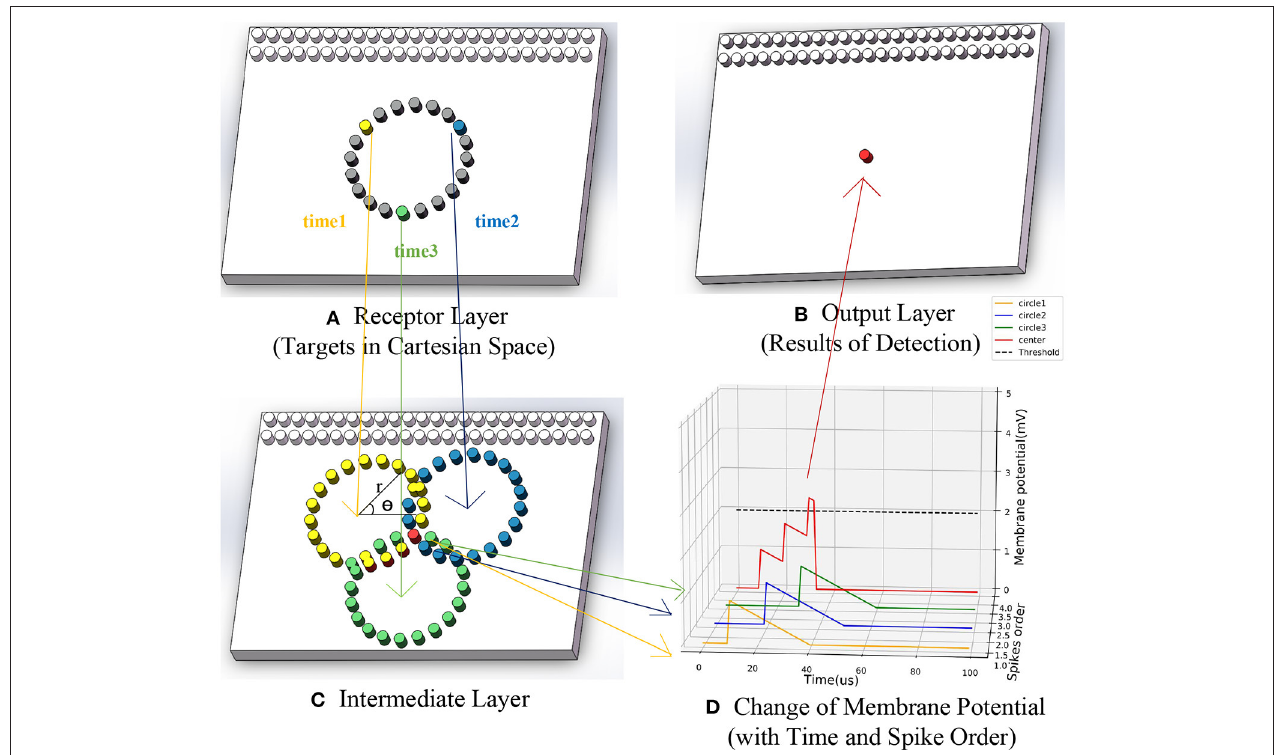
FIGURE 3 | The running process of SNN based asynchronous hough circle transform. (A) Receptor layer (target in Cartesian space). (B) Output layer (results of detection). (C) Intermediate layer. (D) Change of membrane potential (with time and spike order).